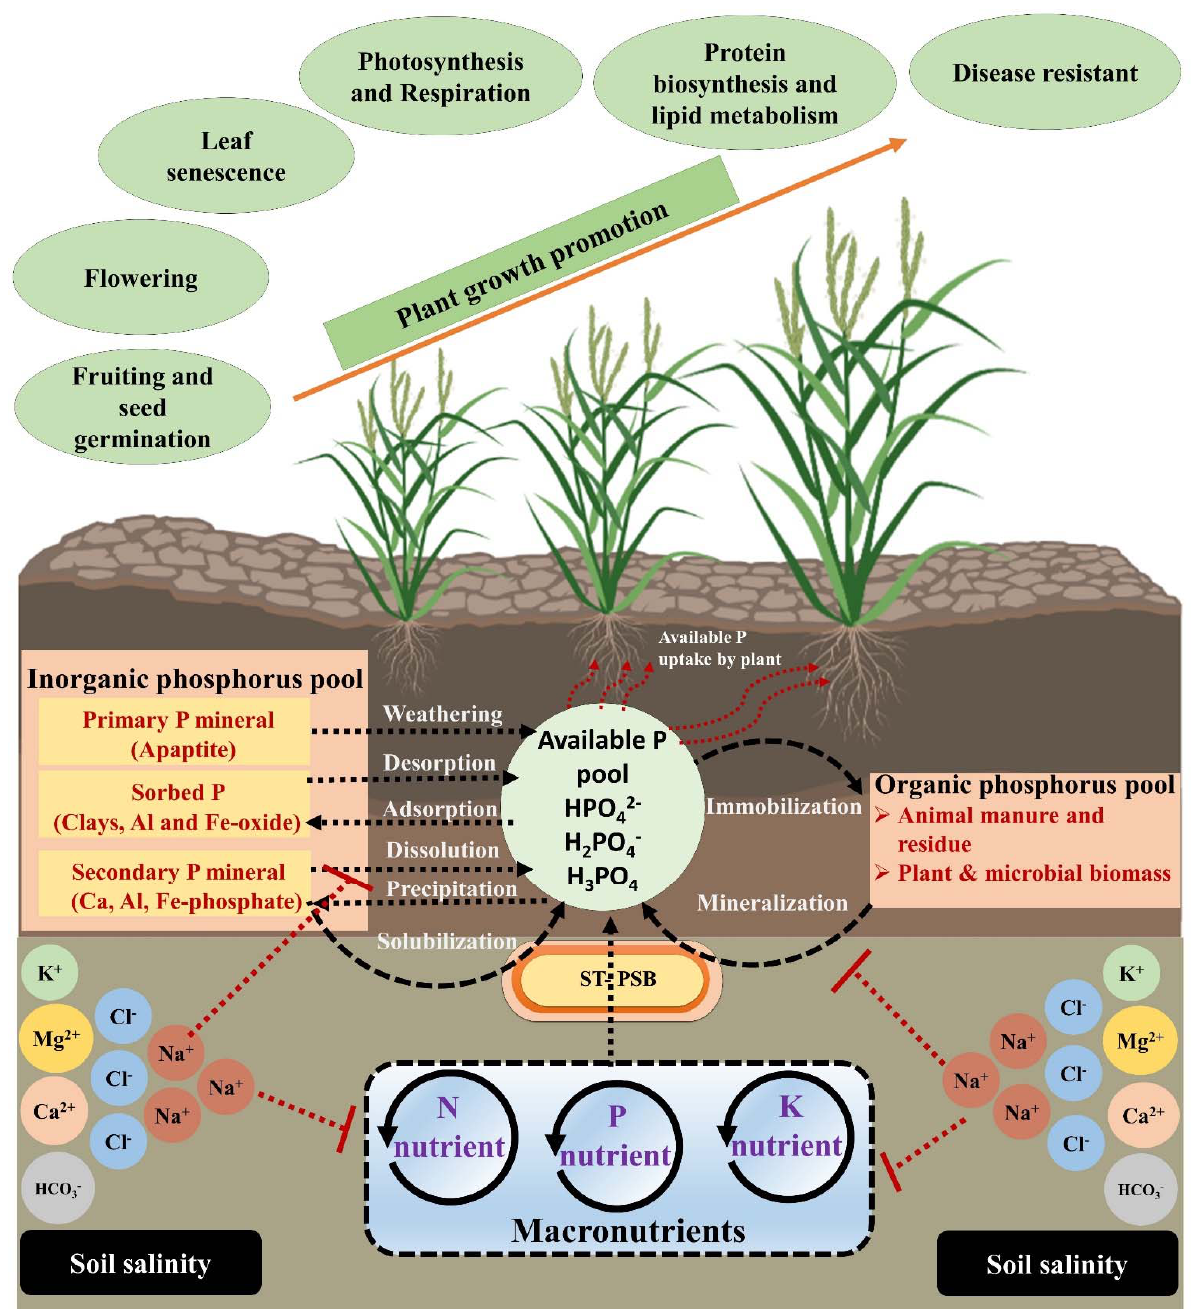
Figure 1. Effect of salinity on P availability and its impact on plant. The orthophosphate in soil is mostly valuable due to its soluble nature, and it exists in three forms viz; mono-hydrogen phosphate (HPO 42 − ), di-hydrogen phosphate (H 2 PO 4 − ), and tri-hydrogen phosphate (H 3 PO 4 ) depending upon the pH condition [54]. The plant cell might consume soluble P in the form of HPO 42 − or H 2 PO 4 − [31]. Phosphorus availability and its uptake by plants in saline environments is affected by several factors in soil-plant environments. A High ionic strength, due to the electrolyte con- centration in saline soil, can lead to enhanced P adsorption and low solubility of P; however, it varies with the different kinds of soil [26]. In alkaline soils, with a high concentration of electrolytes (e.g., Na and Ca), P adsorption increases through Na–P and Ca–P precipitation. In acidic soil, the formation of Al–P increases with the elevated concentration of salt